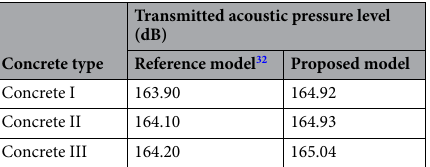
Table 4. Transmitted acoustic pressure levels for the reference and the proposed